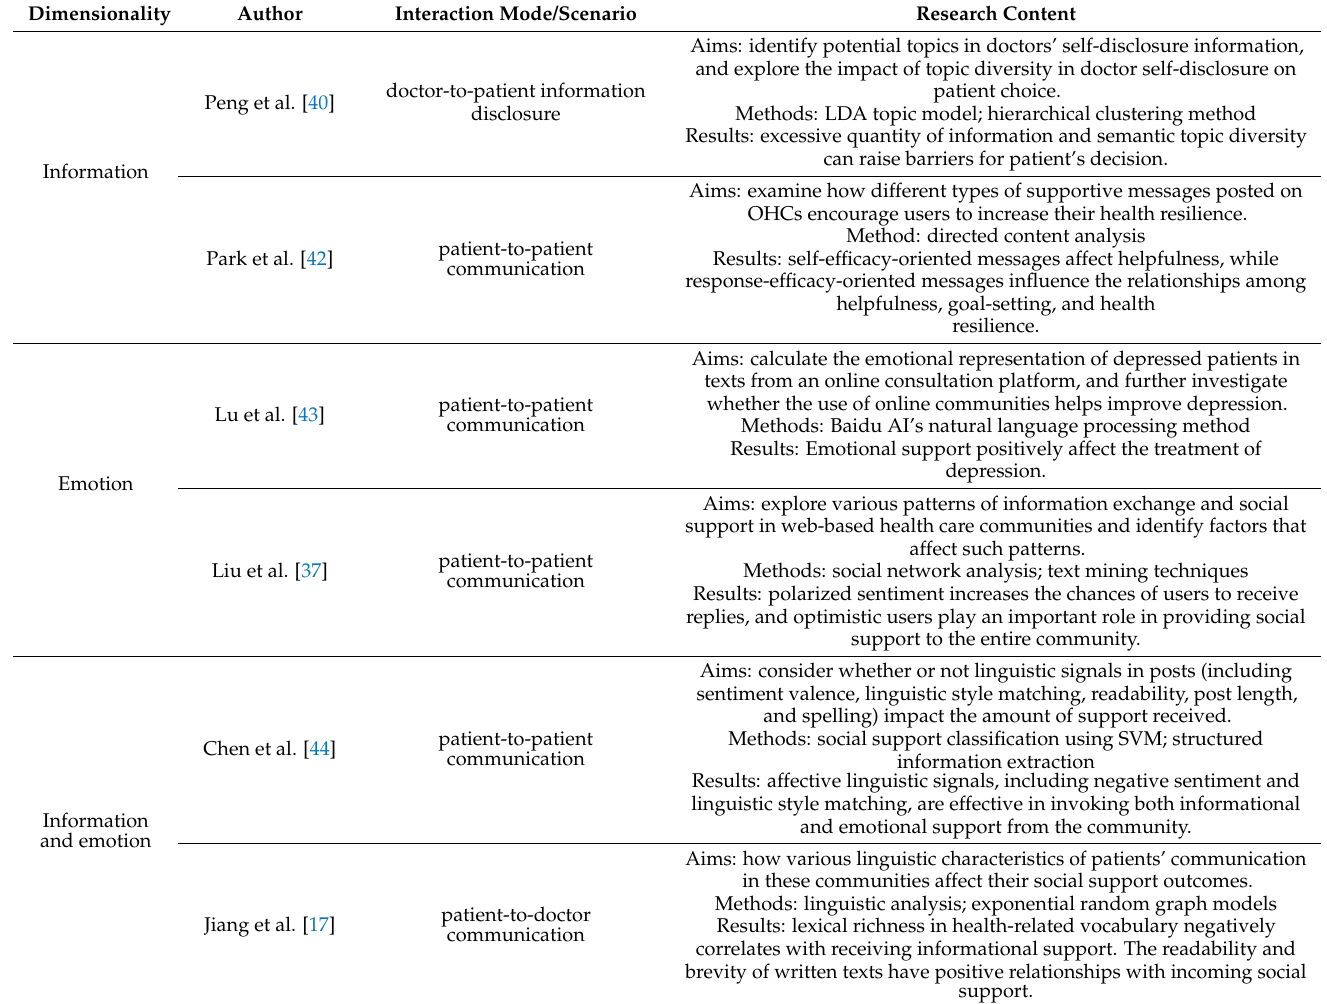
Table 2. Application of text mining in online consultation